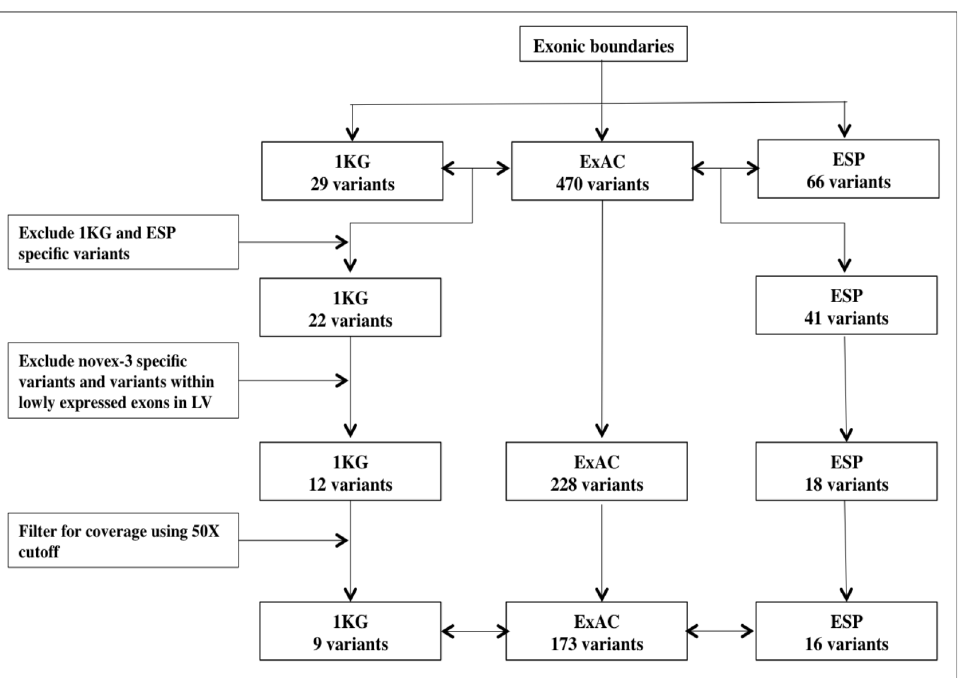
Fig 2. Flowchart for analysis of TTN truncations in publicly available reference populations. Abbreviations: 1KG – 1000 Genomes project; ESP – Exome Sequencing Project; ExAC — Exome Aggregation Consortium; LV – Left ventricle.